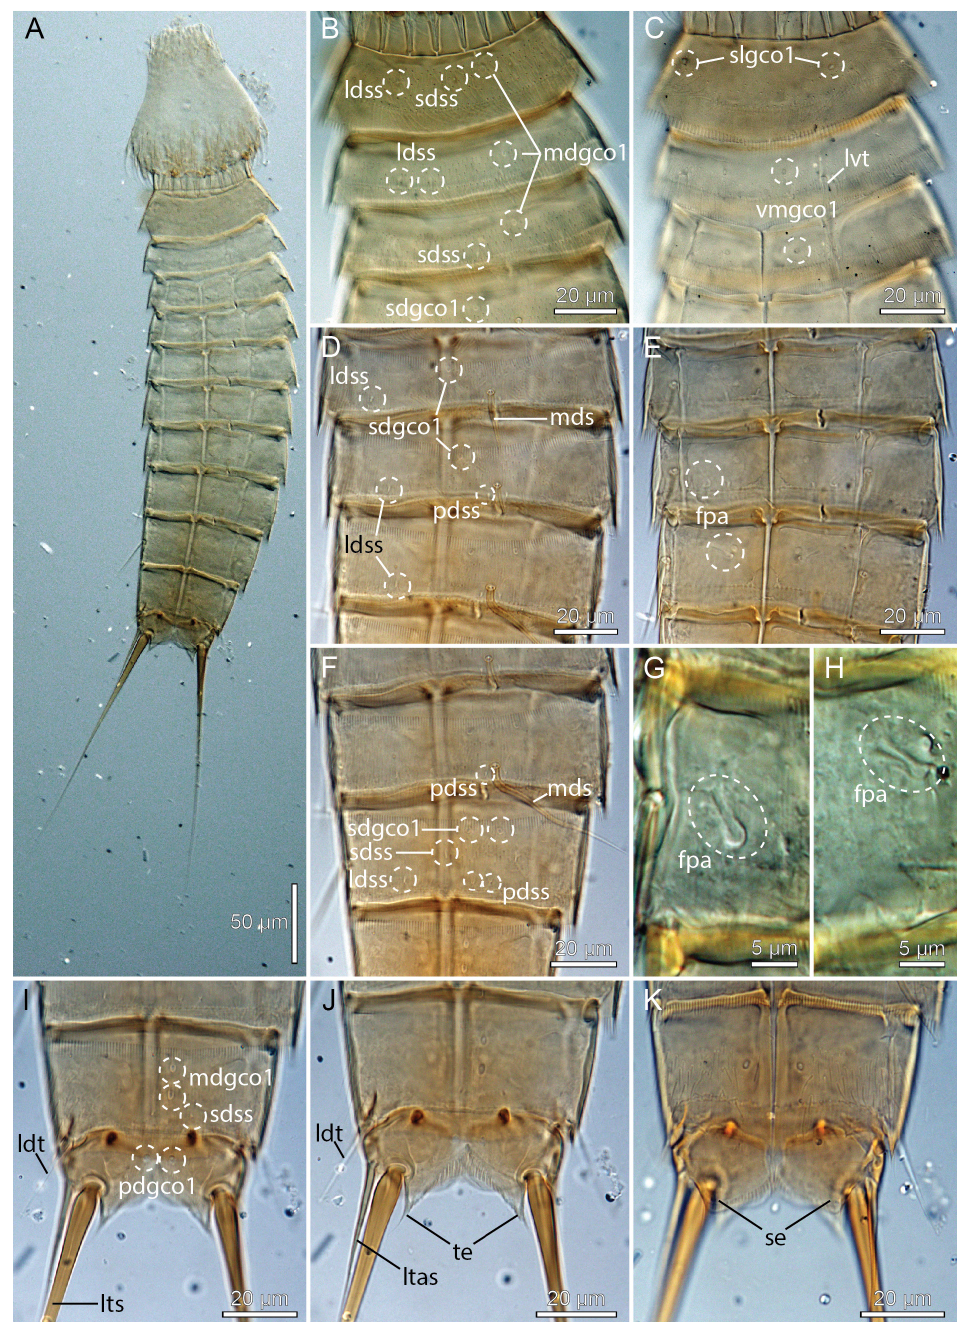
Fig. 16. Light micrographs showing overviews and details of females Echinoderes worthingi Zelinka, 1928. A–F, I–K . Specimen NHMD-644454. G–H . Specimen SMNH-155944A. A . Ventral overview. B . Segments 1 to 3, dorsal view. C . Segments 1 to 3, ventral view. D . Segments 6 to 8, dorsal view. E . Segments 6 to 8, ventral view, showing female sexual dimorphism. F . Segments 8 to 9, dorsal view. G . Detail showing ventromedial female papilla on left sternal of segment 7. H . Detail showing ventromedial female papilla on left sternal of segment 8. I . Segments 10 to 11, dorsal view, showing female sexual dimorphism. J . Segments 10 to 11, focused on tergal extensions and female sexually dimorphic lateral terminal accessory spines. K . Segments 10 to 11, ventral view, showing female sexual